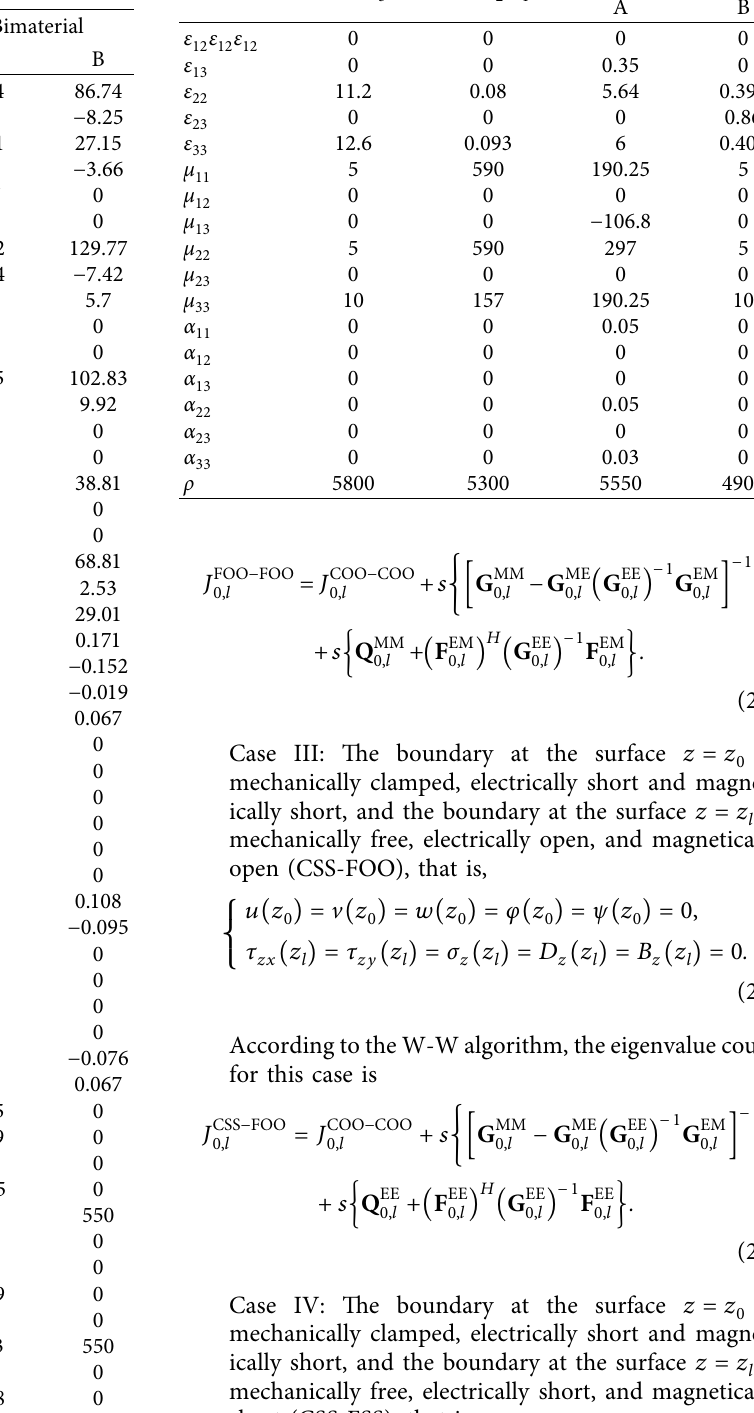
Table 1: Material properties used in the examples: c (10 9 GPa), e (C/m 2 ), h (N/Am), ε (10 − 9 C 2 /Nm 2 ), μ (10 − 6 Ns 2 /C 2 ), α (Ns 2 /C 2 ), and ρ (kg/m 3